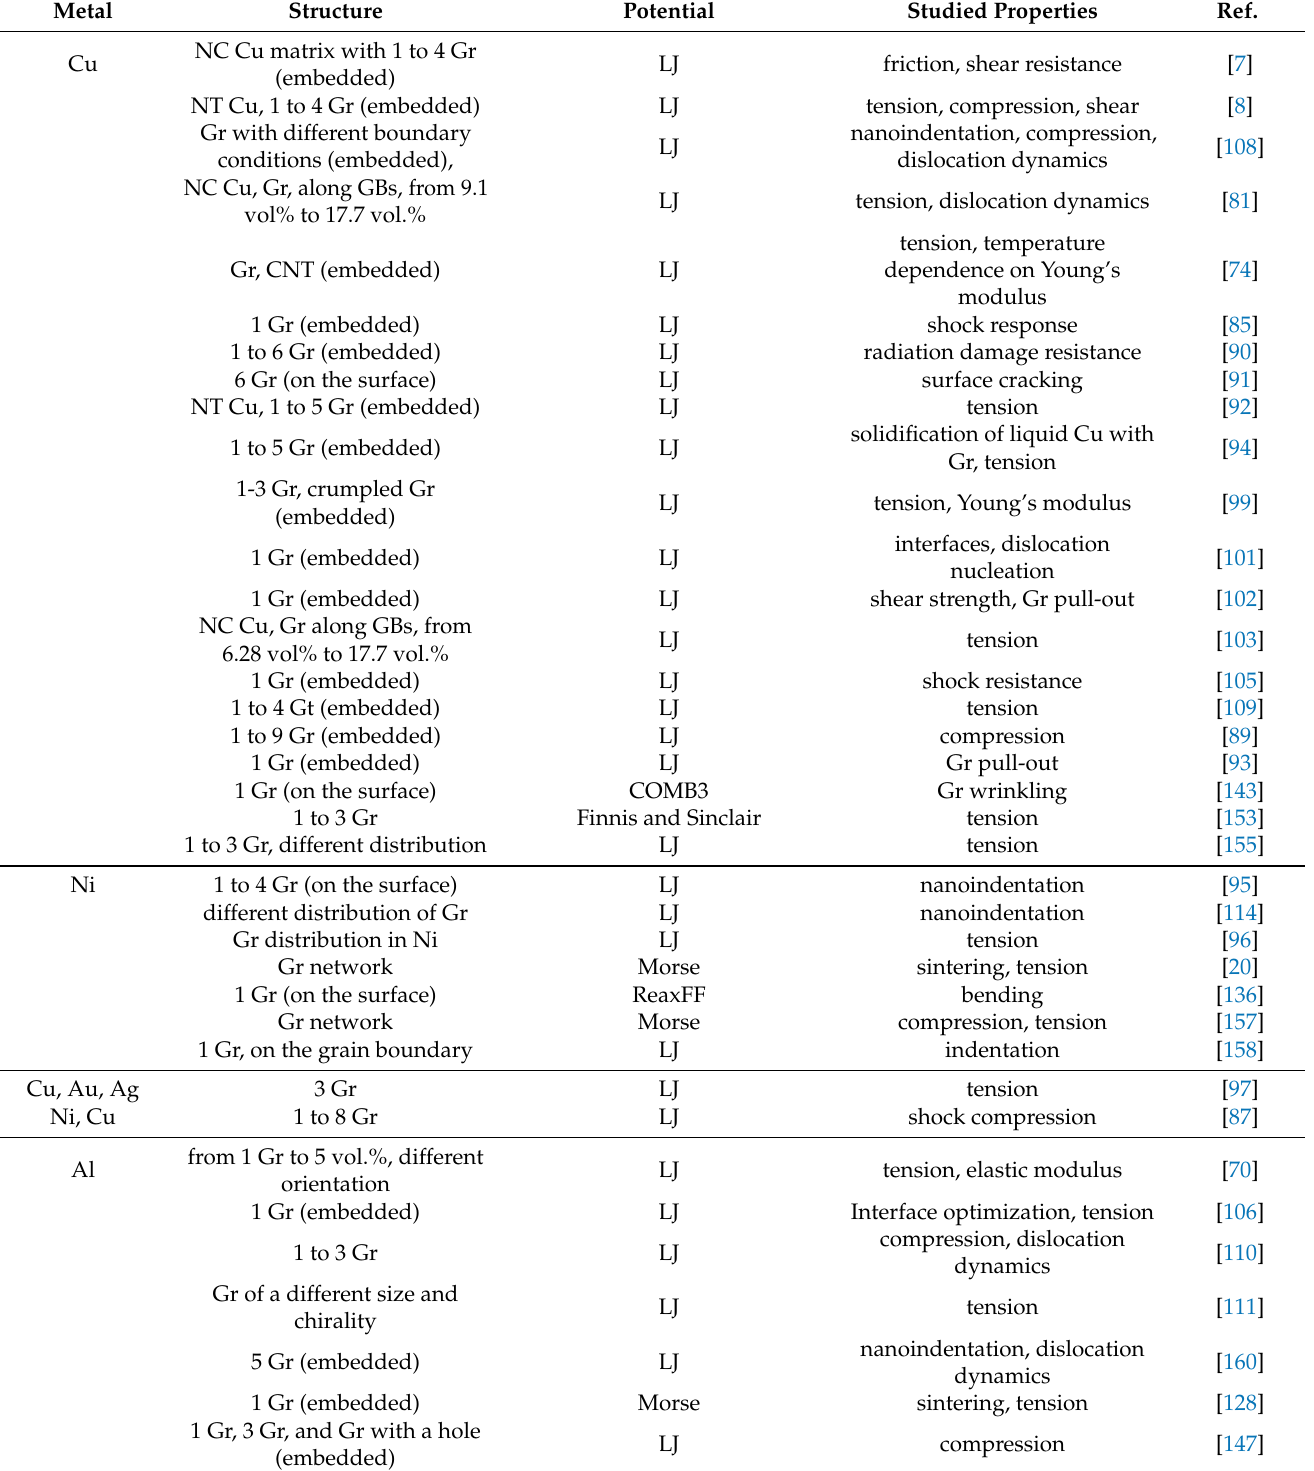
Table 1. Overview of MD simulation and properties of graphene-reinforced MMC. NC is for nanocrys- talline, Gr is for the graphene layer, NT represents nanotwinned, and GB represents the grain